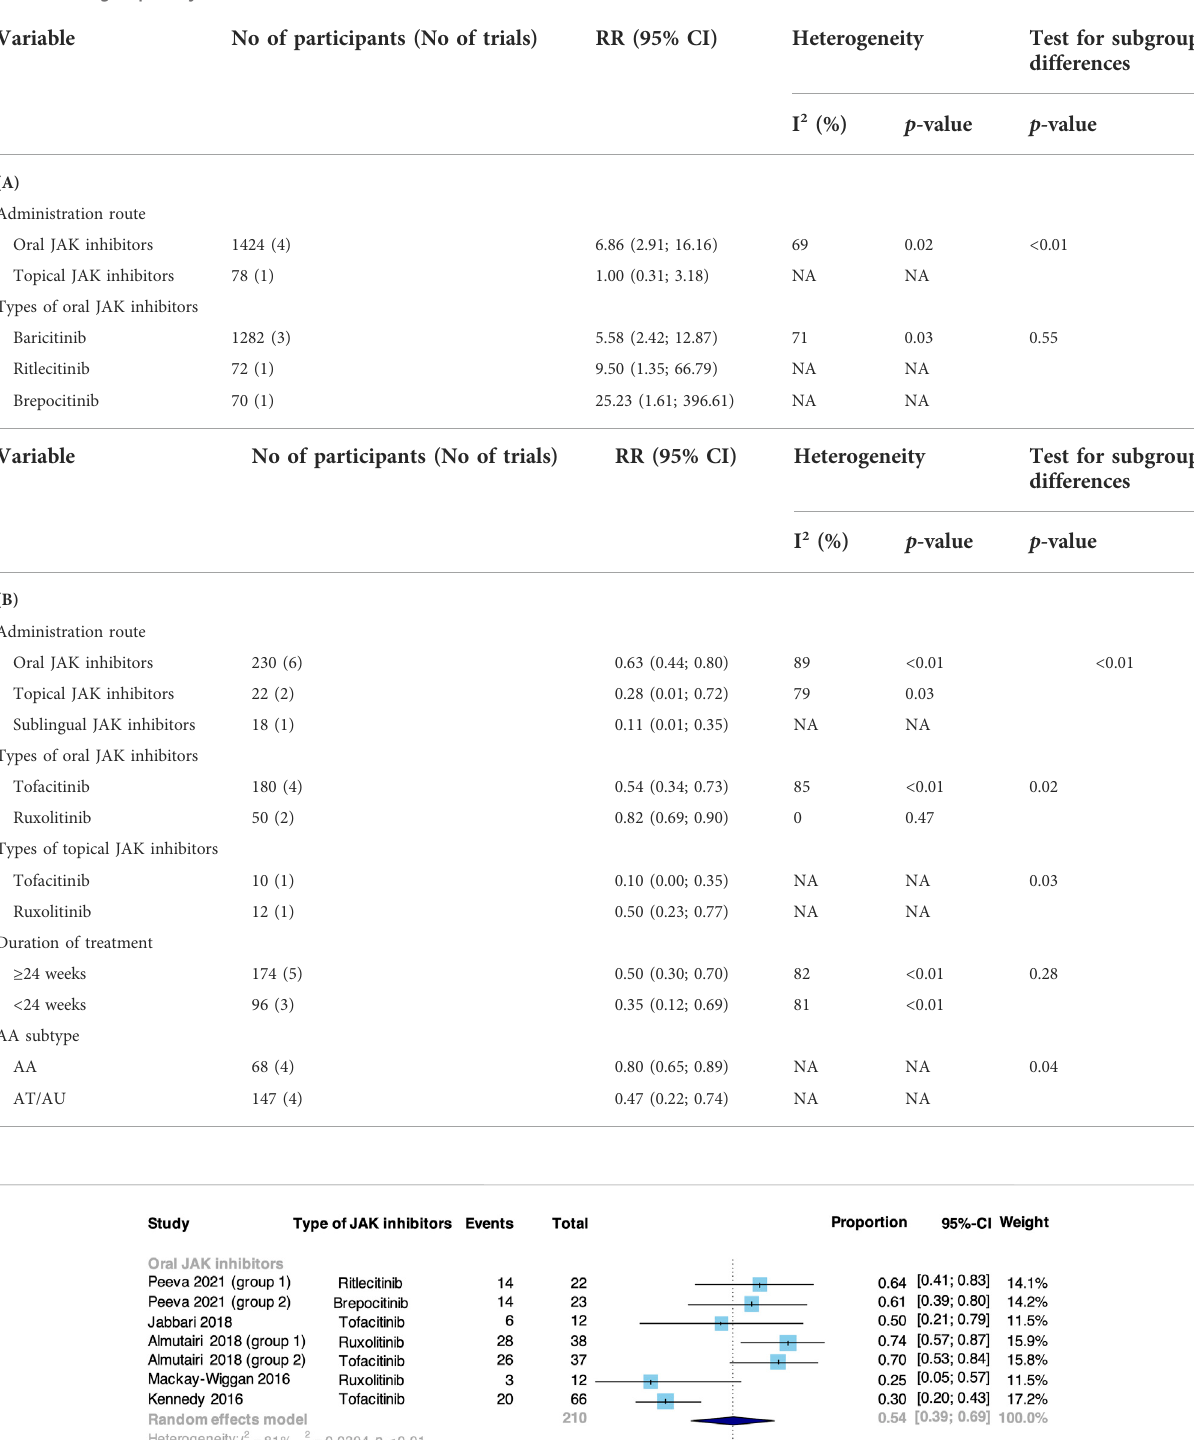
TABLE 3 Subgroup analysis based on (A) RCTs and (B) non-RCTs.